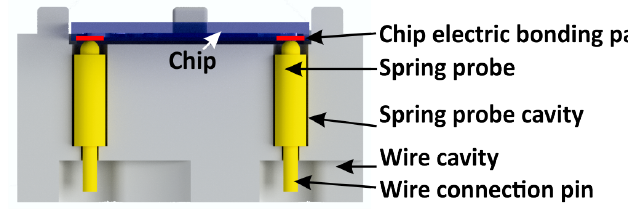
Figure 4. A method to electrically connect a microfluidic chip to the outer world by applying spring probes fitted into a 3D-printed